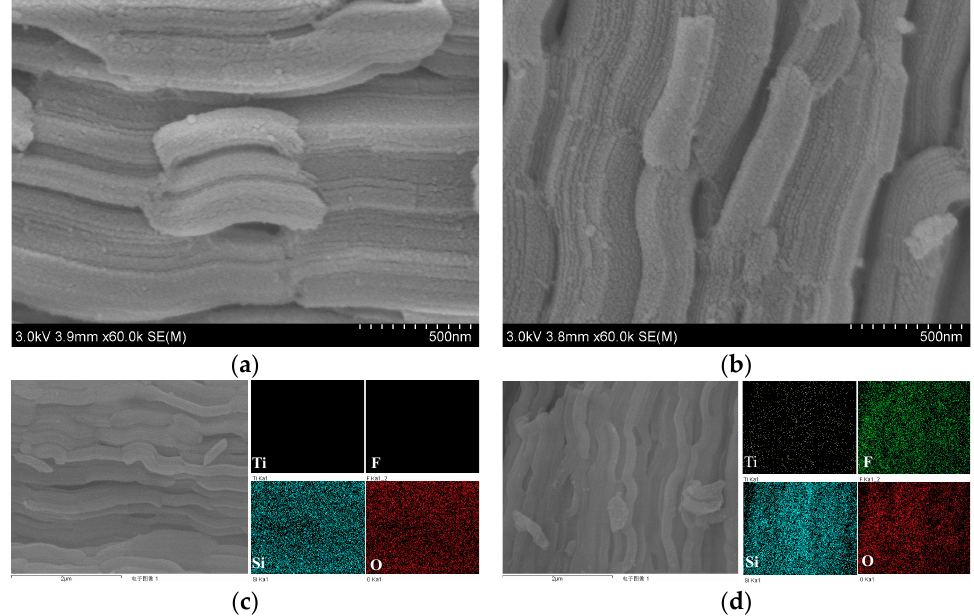
Figure 2. SEM images of the SBA-15 and the 20%-TiO 2 -SBA-15 samples ( a , b ), ( b ) EDS-mapping of the SBA-15 and the 20%-TiO 2 -SBA-15 samples ( c , d ). The wide-angle XRD (Figure 3a) shows peaks at 2 θ values of 24.8, 37.3, 47.6, 53.5, 55.1 and 62.2° reflections of anatase, which match the pattern of JCPDS Card no. 21-1272